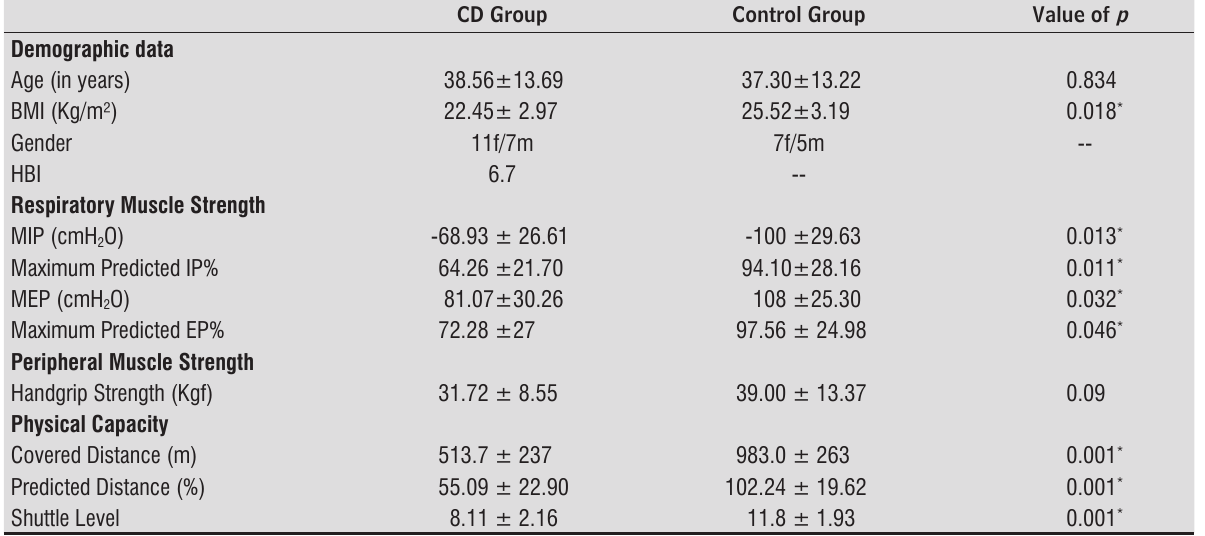
Table1 - Demographic characteristics of muscle strength and physical capability of the sample